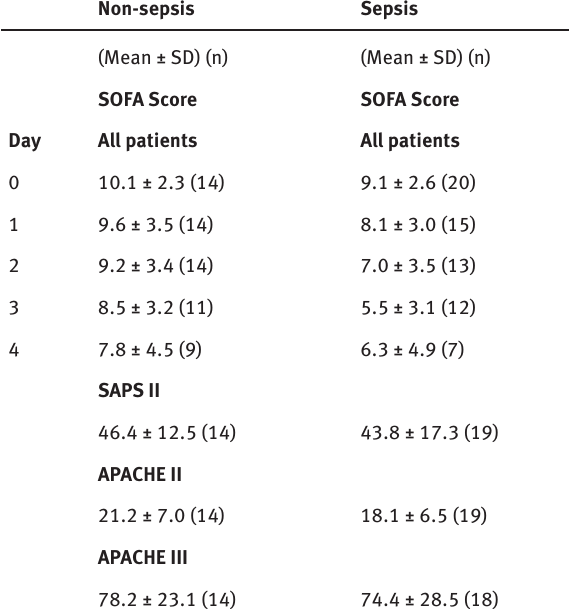
Table 3 : SOFA, SAPS II, and APACHE II and III clinical scoring for non- sepsis and sepsis patients admitted to the medical ICU during the 2015-16 study period. There is no statistically significant difference between non-sepsis and sepsis patients for any assessment score.